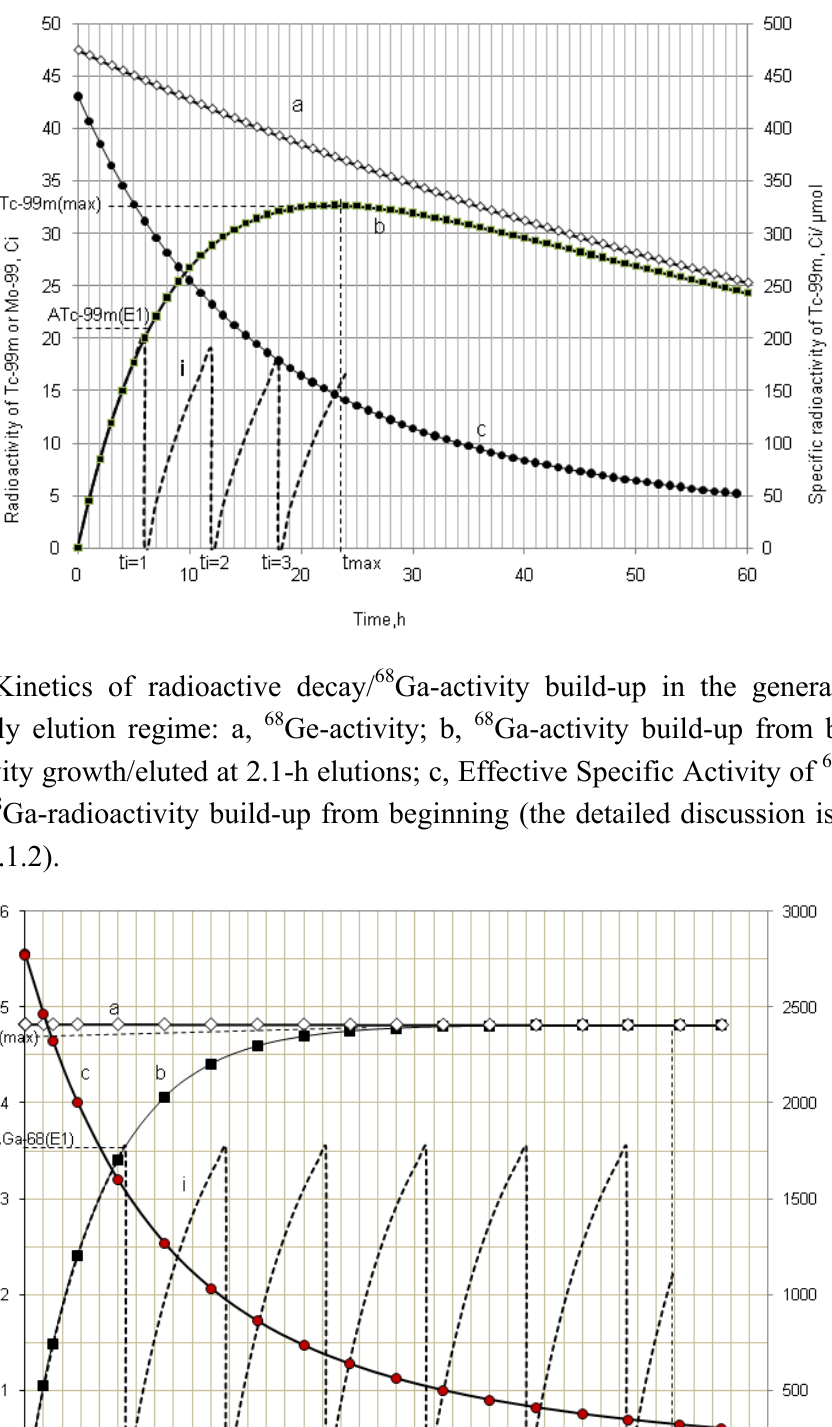
Figure 5. Kinetics of radioactive decay/ 99m Tc-activity build-up in the generator eluted with an early elution schedule: a, 99 Mo-activity; b, 99m Tc-activity build-up from beginning; i, 99m Tc-activity growth/eluted at 6-h elutions; c, Specific Activity of 99m Tc in the system of 99m Tc-radioactivity build-up from beginning (the detailed discussion is available in Section 4.1.2).